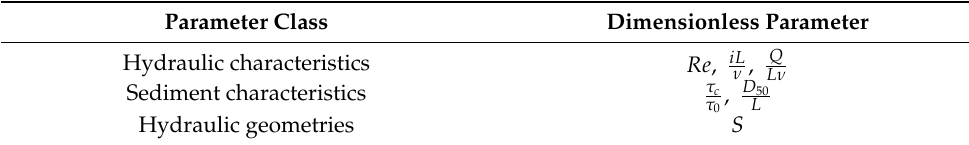
Table 5. Parameter classes and their respective dimensionless group.